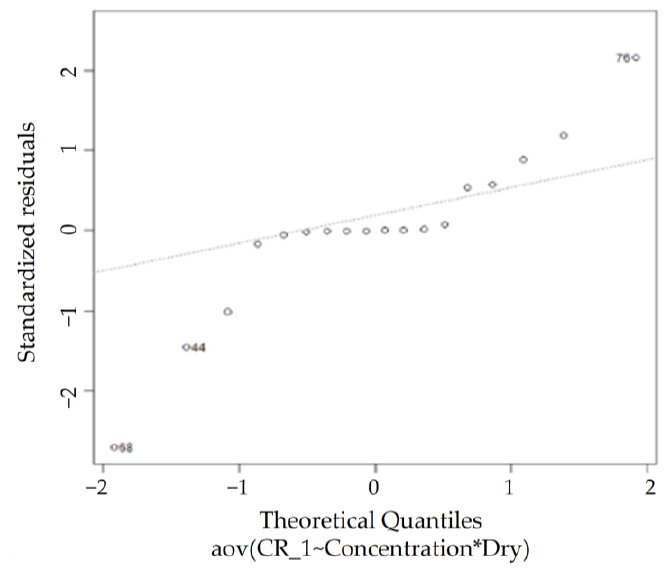
Figure 19. KTD normal QQ plot.